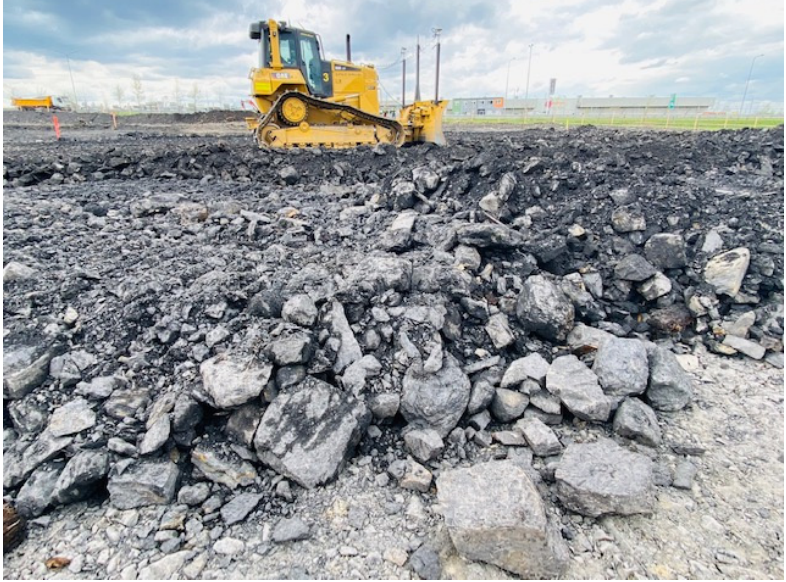
Figure 19. Macro-leveling of the area (Photo by P. Dobrzycki).